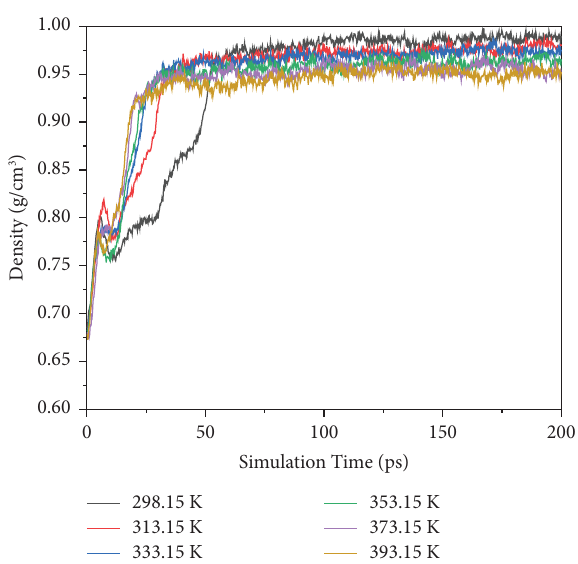
Figure 2: Molecular density values at diferent temperatures. Table 4: Lattice constant of two oxides mineral models. Lattice Mineral oxides